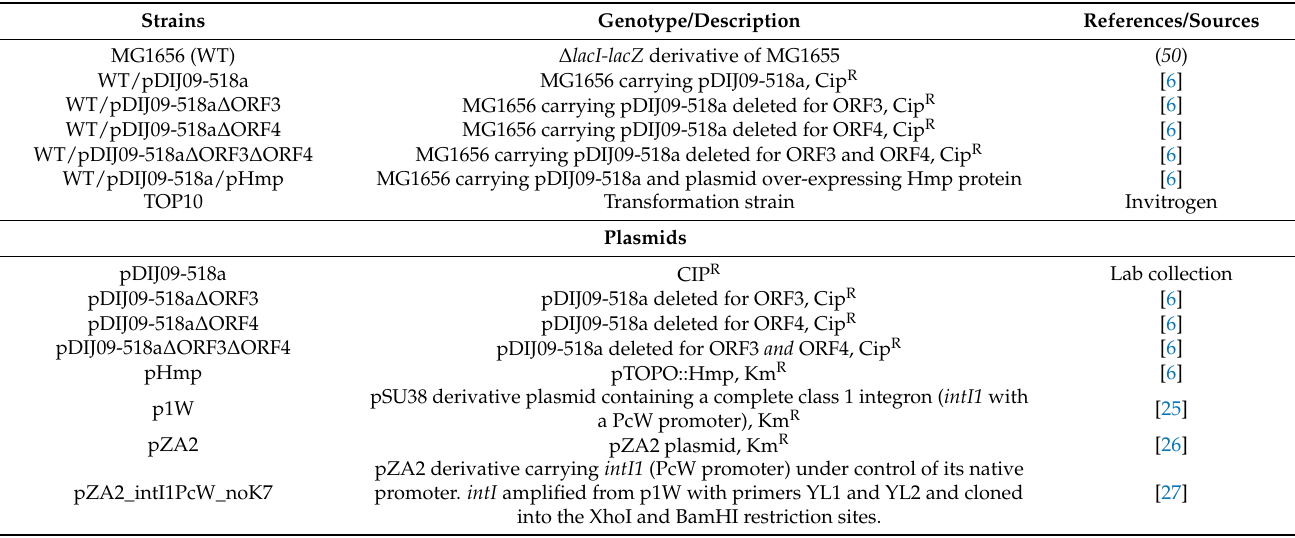
Table 1. Strains and